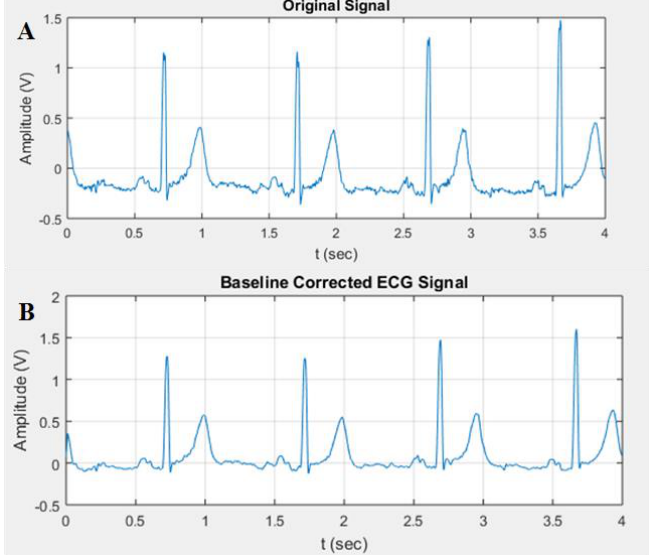
Figure 9. Overall representation of the signal before and after baseline wander correction: ( A ) Original signal; ( B ) baseline corrected ECG signal.